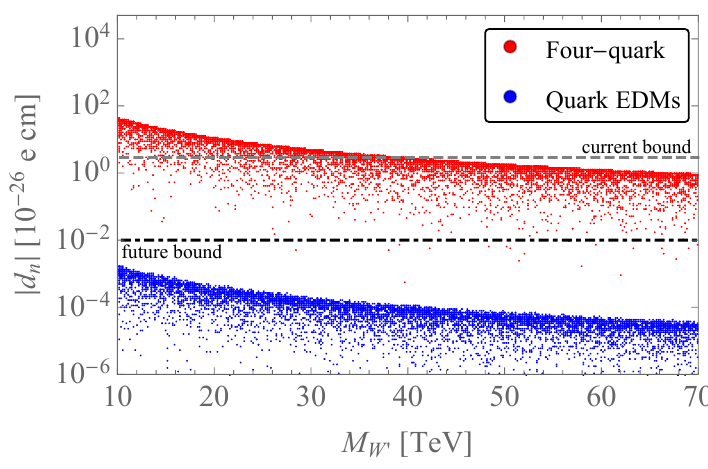
Figure 3 . Prediction for the neutron EDM in the case with (cid:22) (cid:18) = 0 without Peccei-Quinn mechanism. Only the contributions of four-quark operators and quark-level EDMs including both quark EDM and chormo-EDM are shown. A dashed line represents the current bound on the neutron EDM [69], while a dashed dotted line stands for the future bound [71].